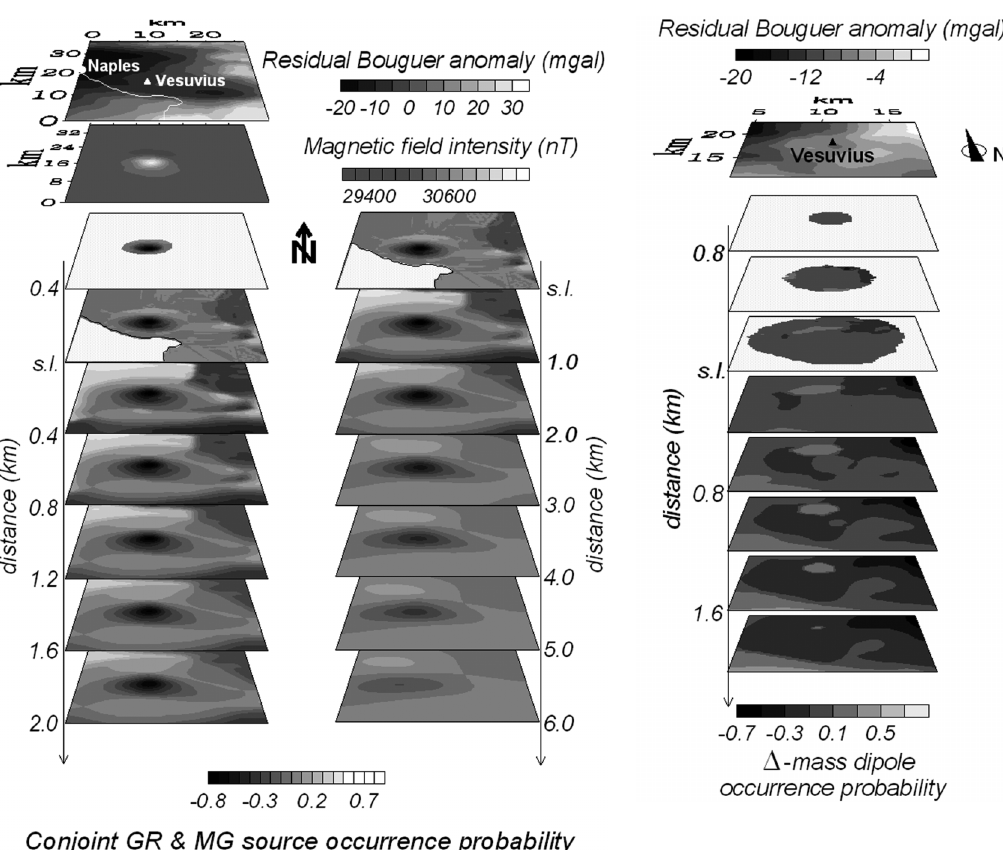
Fig. 5. The Mt. Vesuvius case-history. The integrated gravity and magnetic source probability tomography. The top slices are the reference GR and MG survey maps, already shown in fig.3 and fig.4, respectively. The left-hand tomographic column refers to the depth range from 0.8 km a.s.l. to 2 km b.s.l. with a slicing step of 0.4 km, where- as the right-hand column refers to the depth range from sea level to 7 km b.s.l. with a slicing step of 1 km. Fig. 6. The Mt. Vesuvius case-history. The gravity dipole source probability tomography. The top slice is the scaled reference Bouguer map, extracted from the larger map already shown in fig.3. The following tomograph- ic column refers to the depth range from 0.8 km a.s.l. to 2 km b.s.l. with a slicing step of 0.4 km.